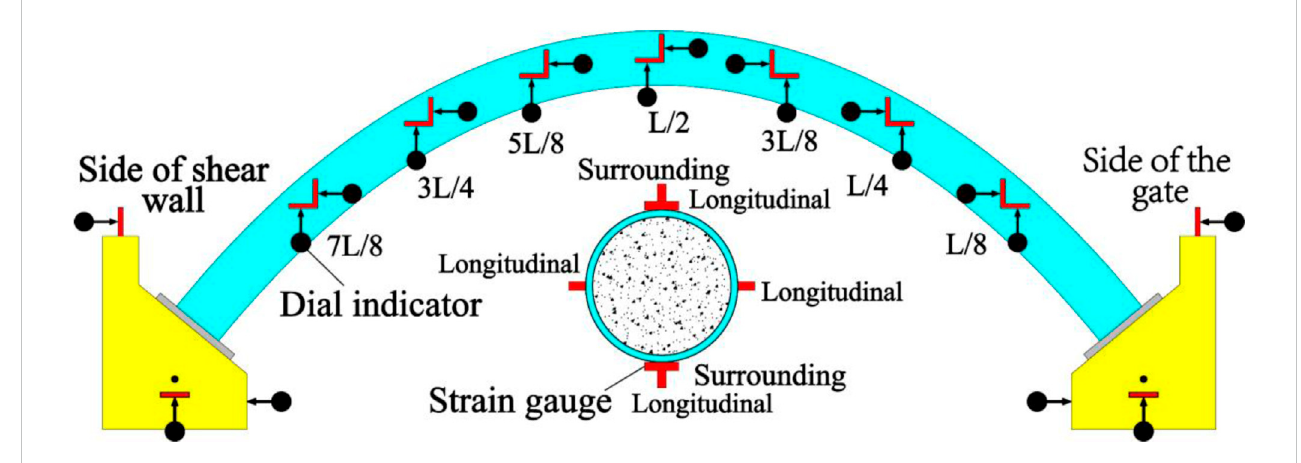
FIGURE 5 Placement of displacement and strain measurement points.